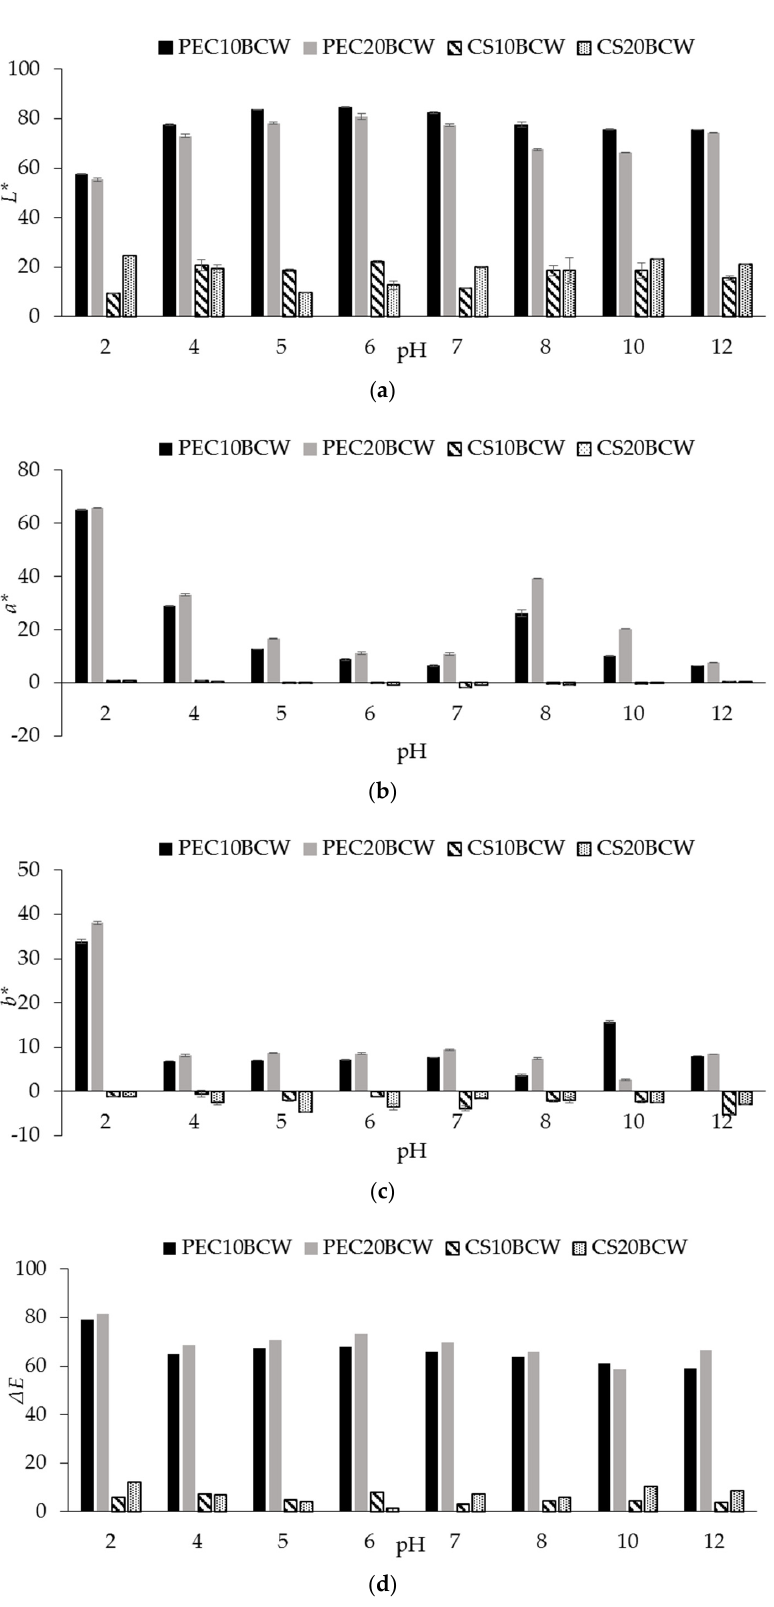
Figure 2. Color parameters of tested film formulations during exposure to various pH ranging from 2 to 12, given as LAB scale values: ( a ) L* ; ( b ) a* ; ( c ) b* and ( d ) ∆ E